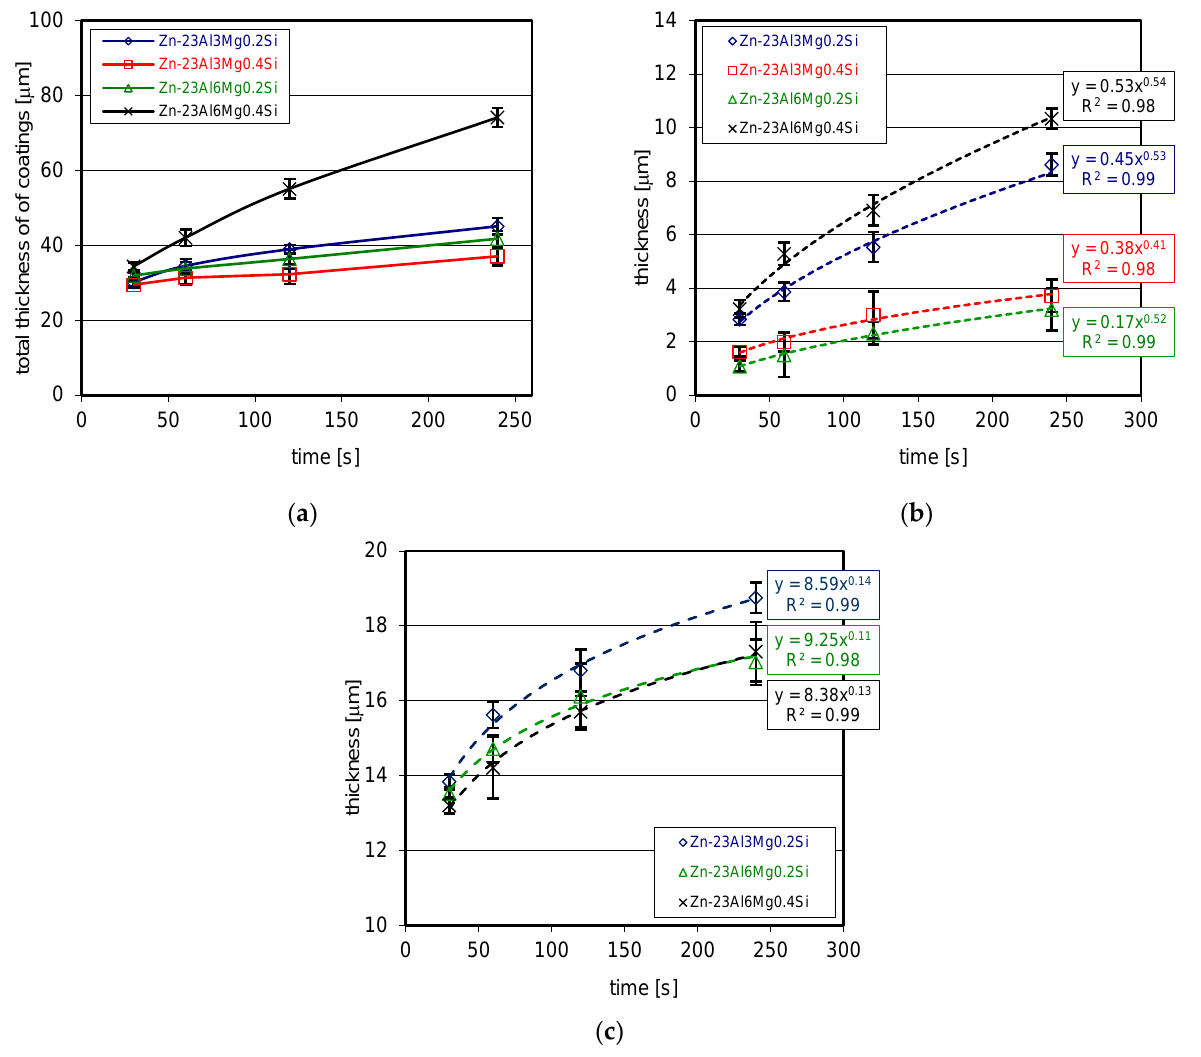
Table 7. Chemical composition of reference ZnAl23Si0.4 bath.